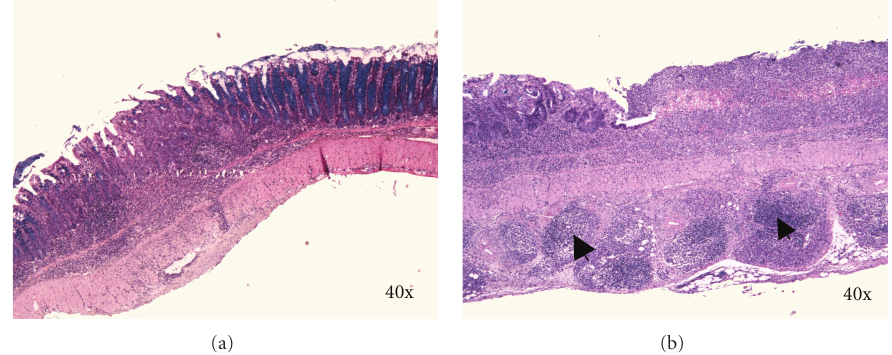
Figure 6: (a) Focal transmural chronic colitis (skip lesion). C57BL/6JOlaHsd female mice are exposed to 3% DSS solution for 5 days followed by drinking water for 28 days. (b) Transmural inflammation with lymphoid follicles in subserosa (arrows) and chronic erosion. C57BL/6JOlaHsd female mice are exposed to 3% DSS solution for 9 days followed by drinking water for 28 days. Kreyberg trichrom stain (acid mucopolysaccharides are stained blue).